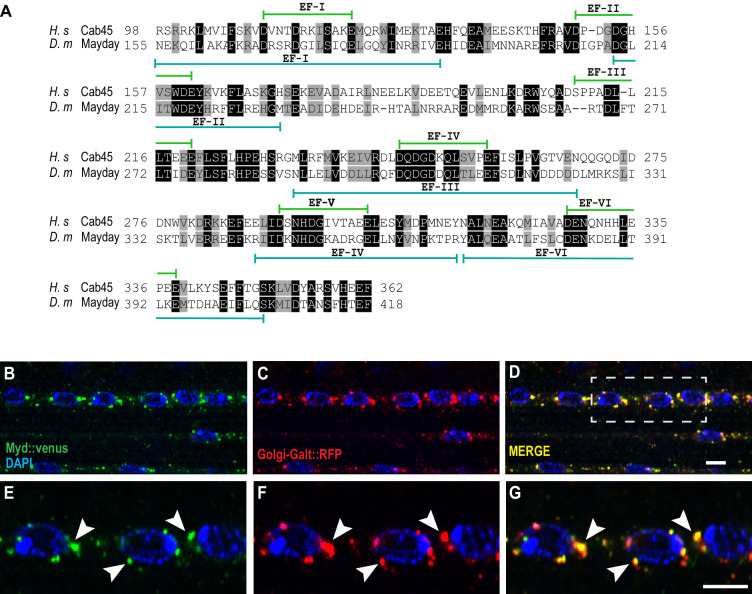
Mayday shares functional homology with human Cab45.(A) Protein alignment between human Cab45 (NP_057260.2) and Drosophila Myd (NP_001262725). Identical amino acids are represented by gray boxes and similarities are shaded black. (B–G) Confocal images of UAS-venus::Myd (green) co-localizing with UAS-Golgi-GalT-RFP (red) and DAPI (blue) at ×63 magnification. The white box in D represents the zoomed in region for panels E-G. Areas of colocalization are marked with white arrowheads. Scale bar in D = 10 µM for panels B-D. Scale bar in G = 6 µM for panels E-G.